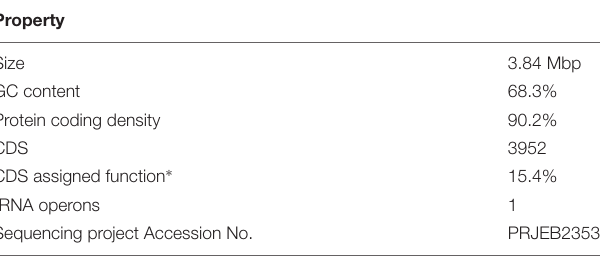
TABLE 2 | Genome properties of the closed Micropruina glycogenica Lg2 T genome.